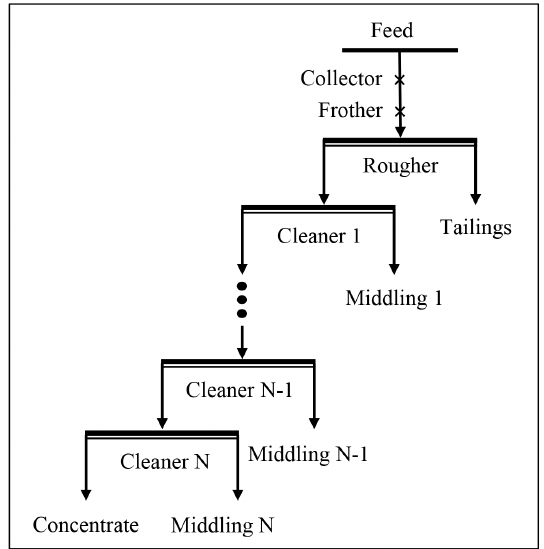
Figure 1. Schematic representation of the multi-stage flotation circuit.